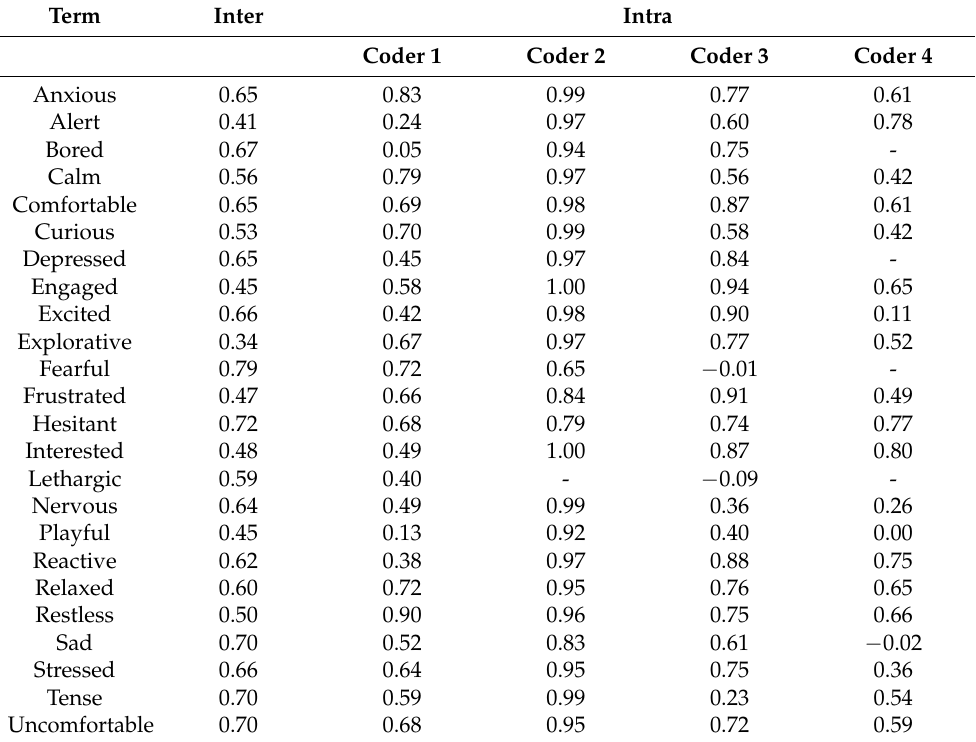
Table 3. Intraclass correlation coefficients indicating levels of agreement both between coders (inter- rater reliability) and within each of the four coders (intra-rater reliability) for each term of the QBA.